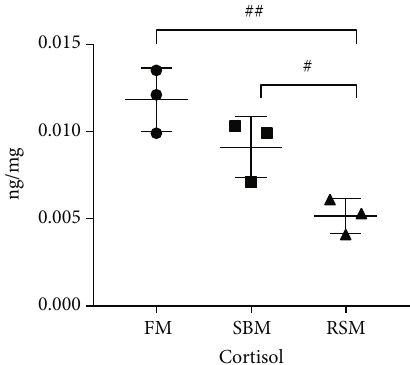
Figure 5: E ff ect of di ff erent dietary protein sources on gonadal cortisol concentrations of female yellow cat fi sh broodstock. Values are expressed as means ± SE ( n = 3 ); # represents the statistically signi fi cant di ff erences ( P < 0 : 05 ), and ## represents the extremely signi fi cant di ff erences ( P < 0 : 01